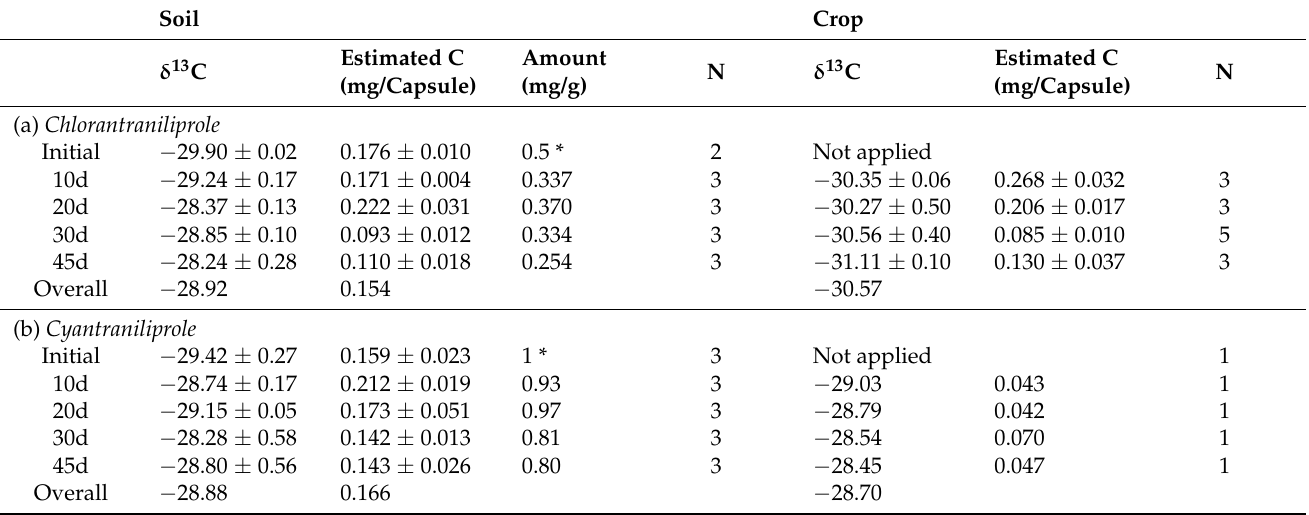
Table 1. Carbon isotope variability of chlorantraniliprole and cyantraniliprole extracted from samples. Soil